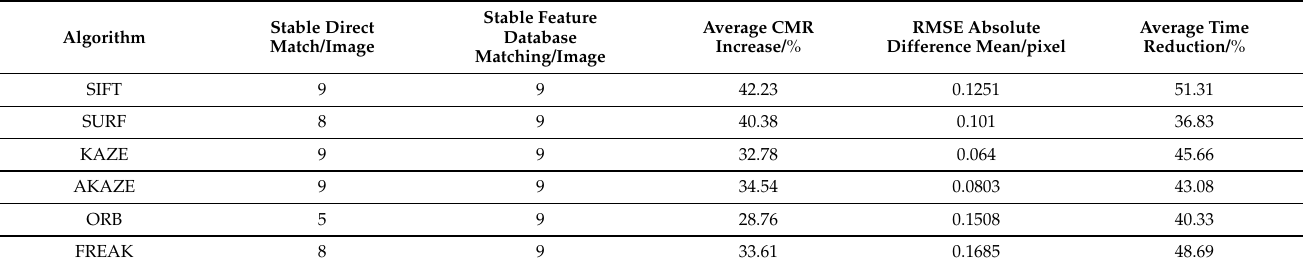
Table 5. Comparison of parameters between direct matching method and feature database match- ing